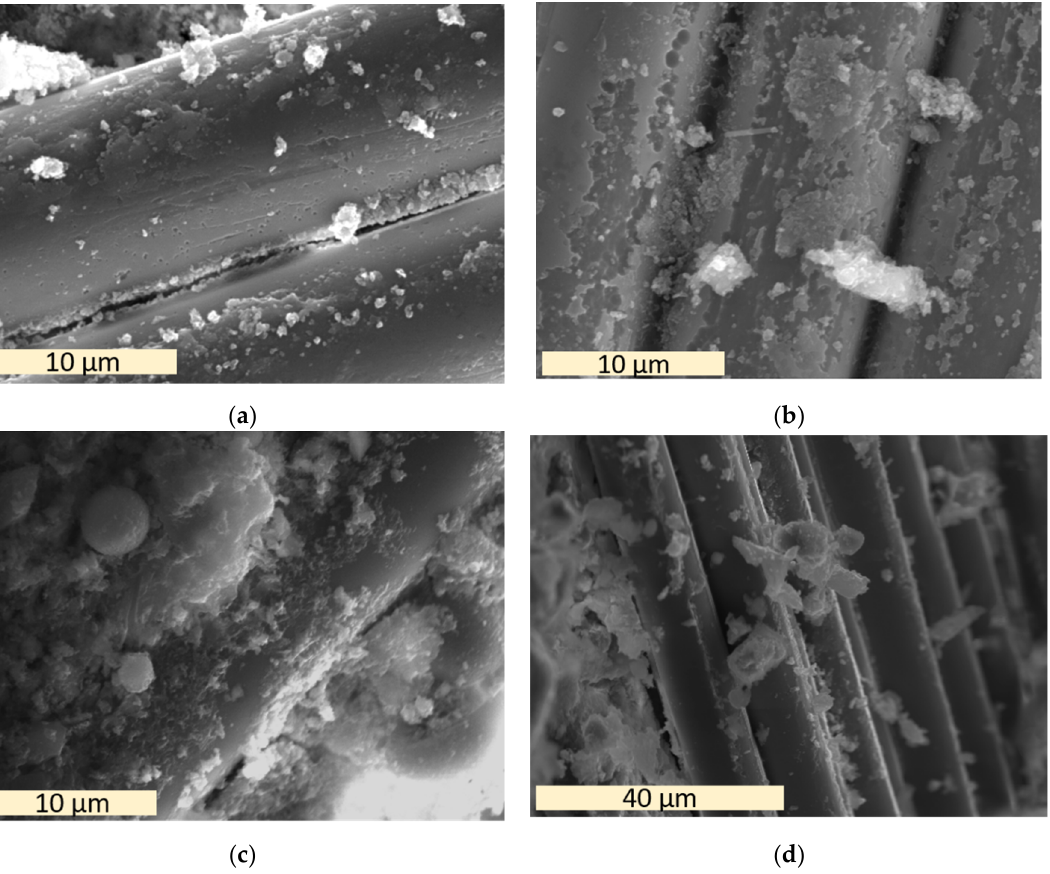
Figure 4. AR fibers extracted from the GRC composites: control composite (C) after standard curing (SC, ( a )) and after aging (SC+Ag, ( b )); the GFA60 composite after SC+Ag ( c ); and the GFA50+SSF10 composite after SC+Ag ( d